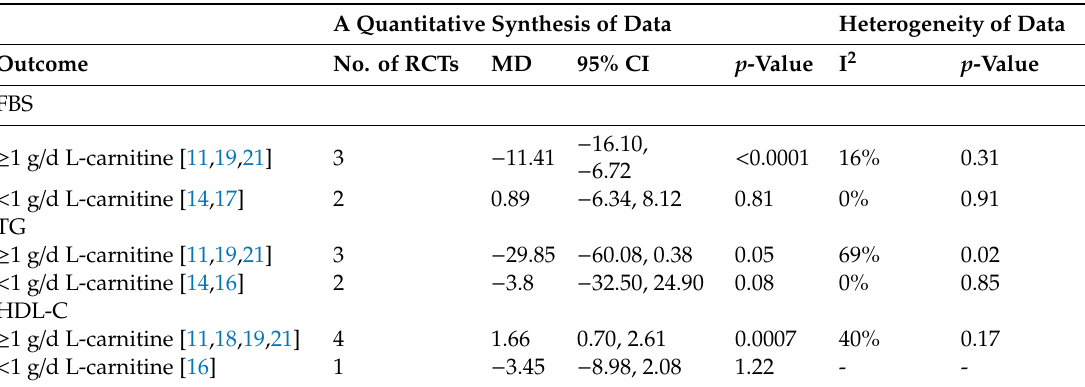
Table 4. Subgroup analysis by L-carnitine dose. A Quantitative Synthesis of Data Heterogeneity of